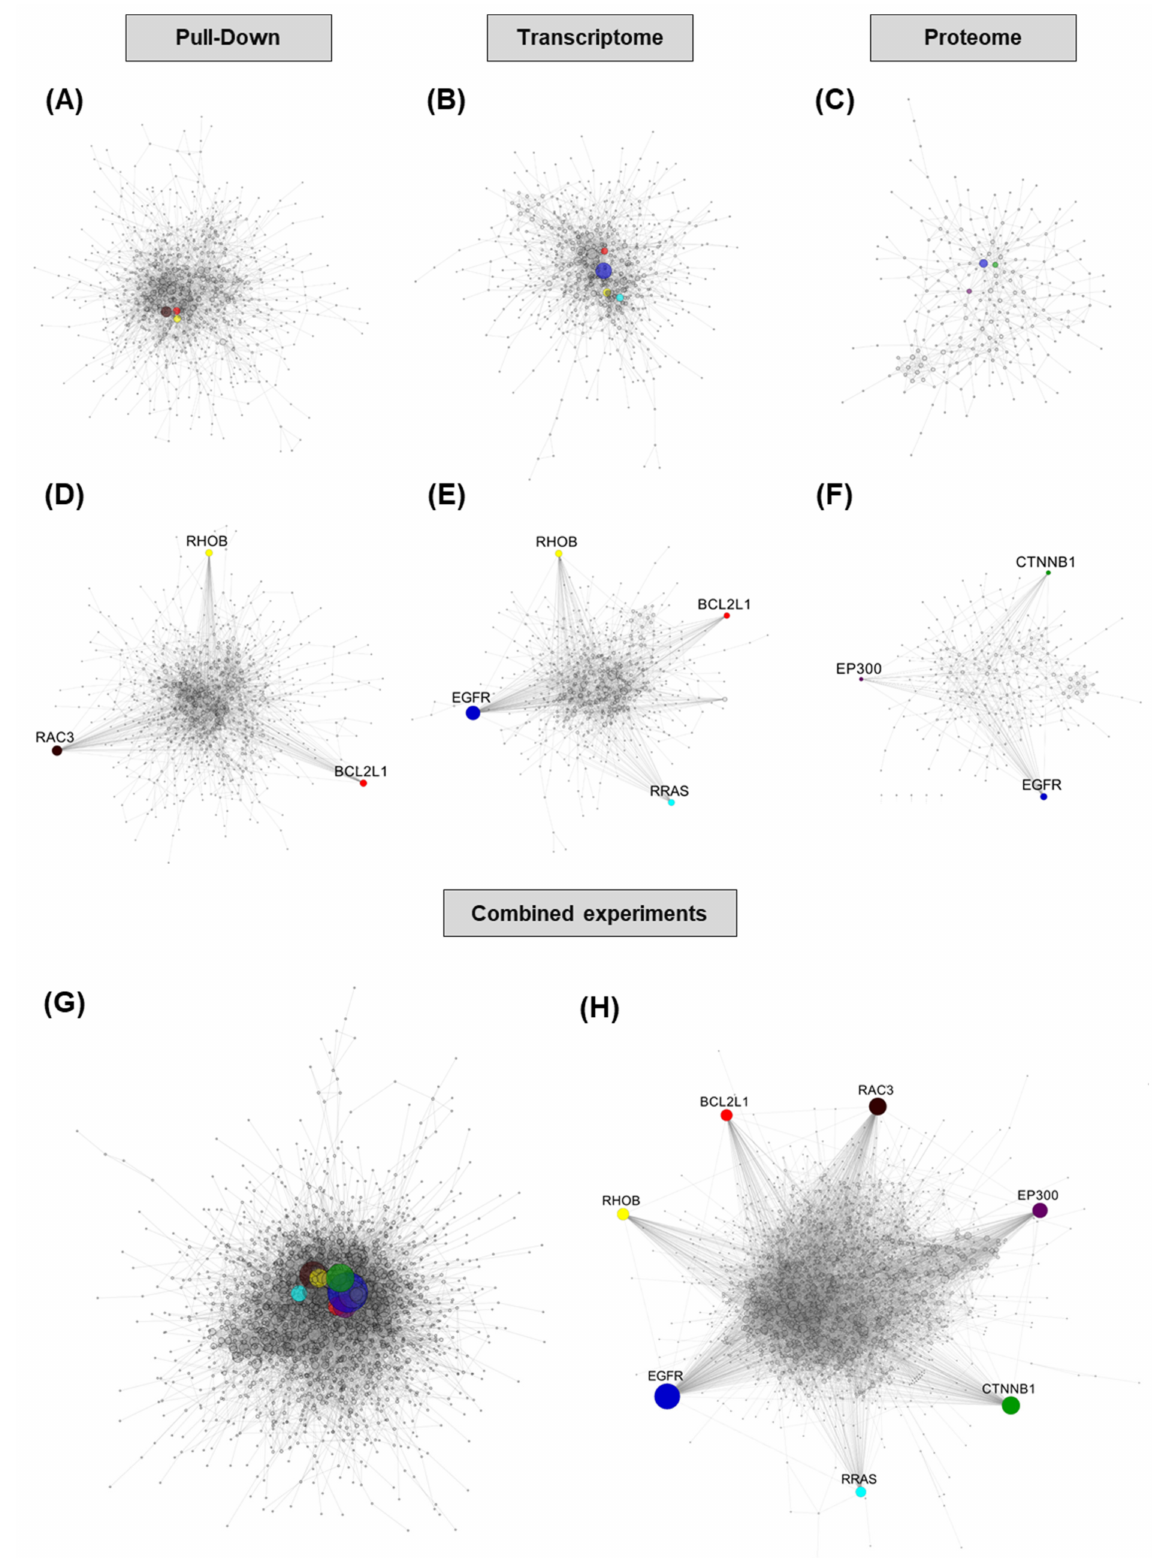
Figure 4. PPI network construction identifies highly connected hubs within miR-491-5p-regulated genes. PPI network constructed wit gene lists from individual ( A – C ) or combined ( G ) analyses. Node size scales with connectivity. Hubs representing genes selected as potentially druggable targets have been colored. Selected hubs are positioned in the outskirts of the network ( D – F , H ) to better visualize their